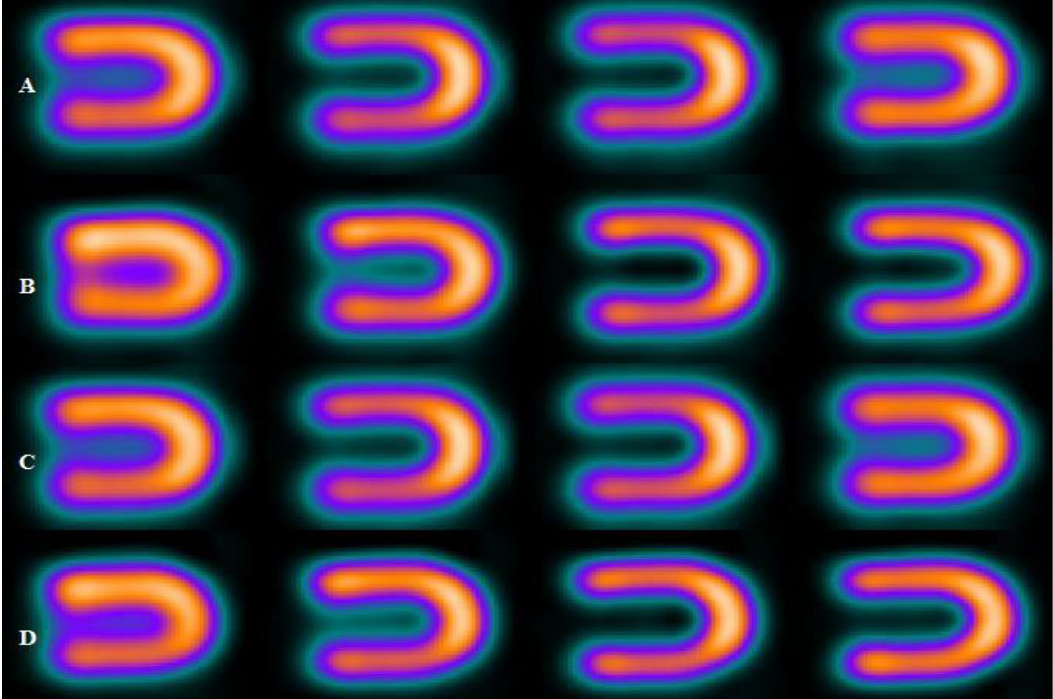
Figure 5. Defect in interior and inferior region of myocardial SPECT image using 25% energy win- dow at four positions, where the rows (A, B, C, and D) at (the center, 5 cm, 10 cm, and 15 cm), respectively.